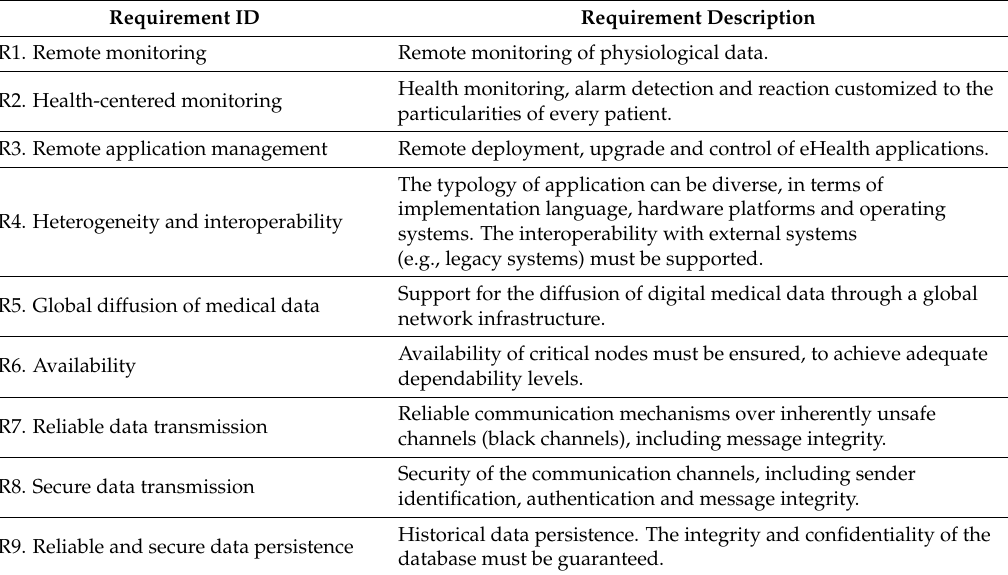
Table 1. Requirements of the target